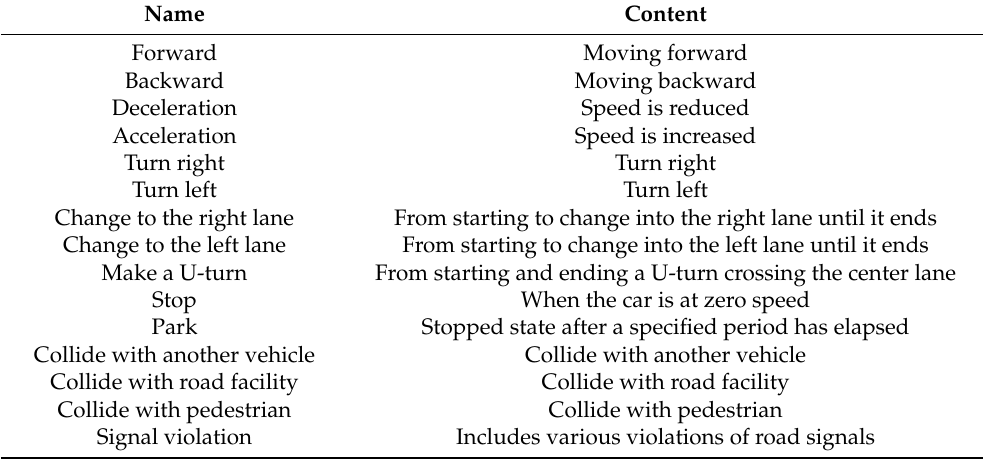
Table 4. List of action labels to apply to a vehicle. Name